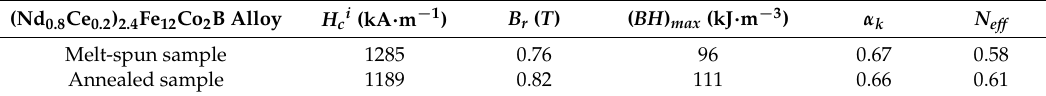
Figure 2. ( H ci ) 1/2 as a function of T 2/3 ( a ), and plots of µ 0 H c (T)/M s (T) versus µ 0 H Nmin ( T ) /M s ( T ) ( b ), in the temperature range of 300–500 K for melt-spun (Nd 0.8 Ce 0.2 ) 2.4 Fe 12 Co 2 B ribbons and samples annealed at 773 K for 15 min with 1 T magnetic field. Table 1. The intrinsic coercivity ( H ci ), the remanence ( B r ), maximum energy product (( BH ) max ), the microstructural parameters α k , and N eff of melt-spun (Nd 0.8 Ce 0.2 ) 2.4 Fe 12 Co 2 B sample and annealed sample at 773 K for 15 min with 1 T magnetic field.